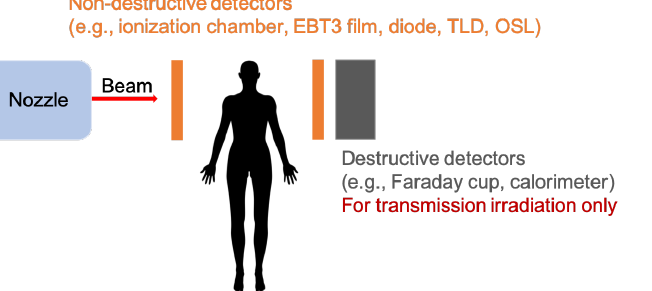
Figure 2. Destructive and non-destructive detectors for dosimetry. The former may be used on either side of the patient, while the latter can serve beam stopper only in the case of transmission